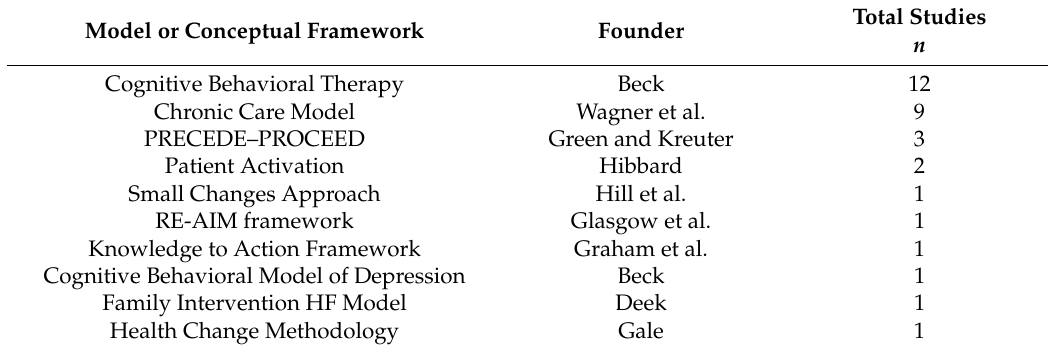
Table 3. Models or conceptual frameworks (31 studies).